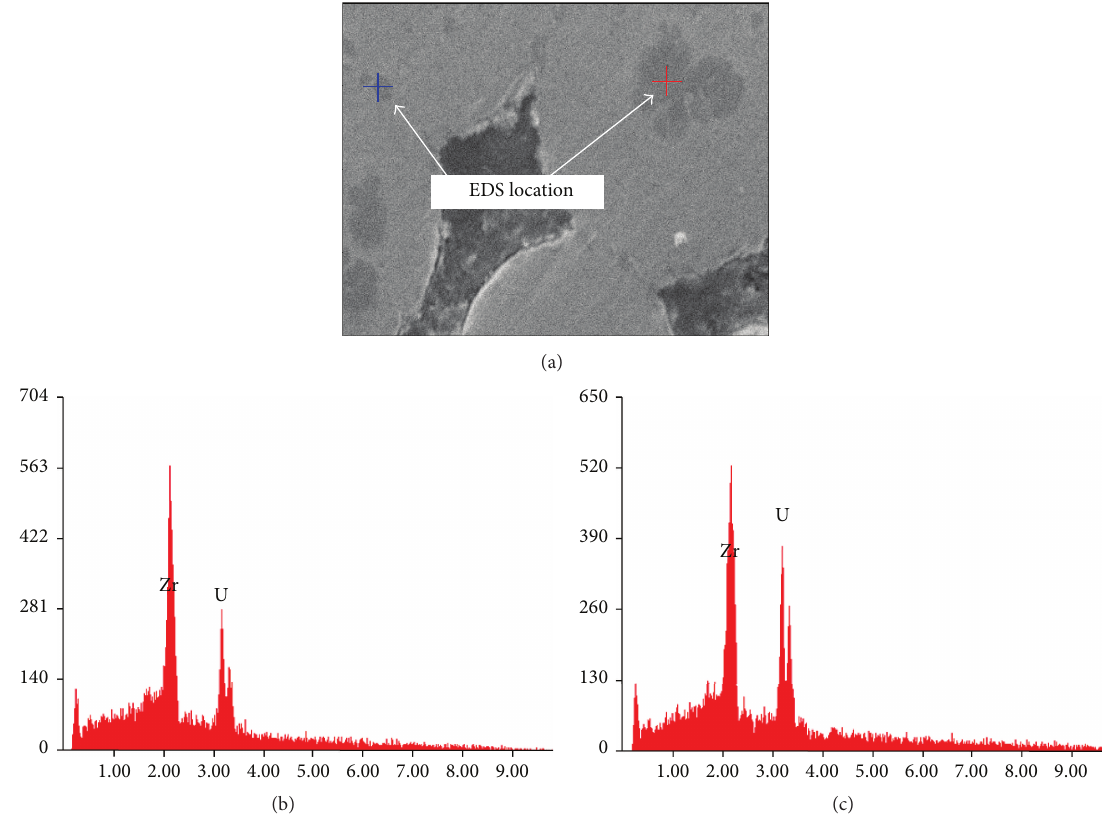
Figure 5: (a) Magnified micrograph of sample E ( − 325 mesh) sintered at 1100 ∘ C for 1h and EDX spectra at the inclusion existing (b) within the particle and (c) at the interface of the